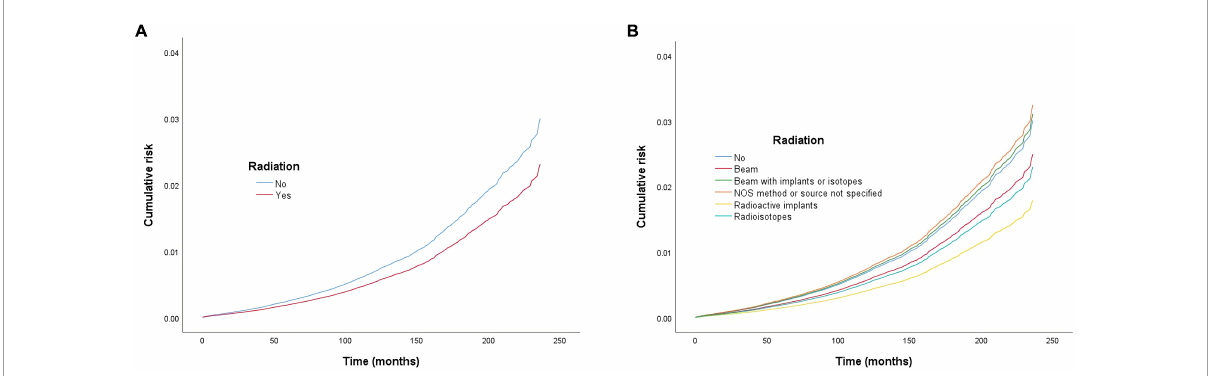
FIGURE3 Cumulative risk of cardiac-specific death related to radiation therapy (RT) after propensity score matching (PSM). The Y -axis of each panel shows the cumulative risk of cardiac-specific death and the X -axis shows the time since diagnosis in months. Each line represents the cumulative risk of cardiac-specific death in patients after receiving a treatment. (A) Cumulative risk of cardiac-specific death in patients with receiving and not receiving radiotherapy. (B) Cumulative risk of cardiacspecific death in patients with not receiving radiotherapy and receiving different modalities of radiotherapy.